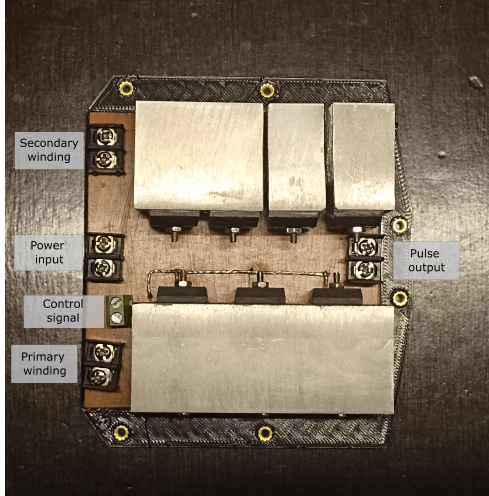
Figure 3. Assembled pulse generator